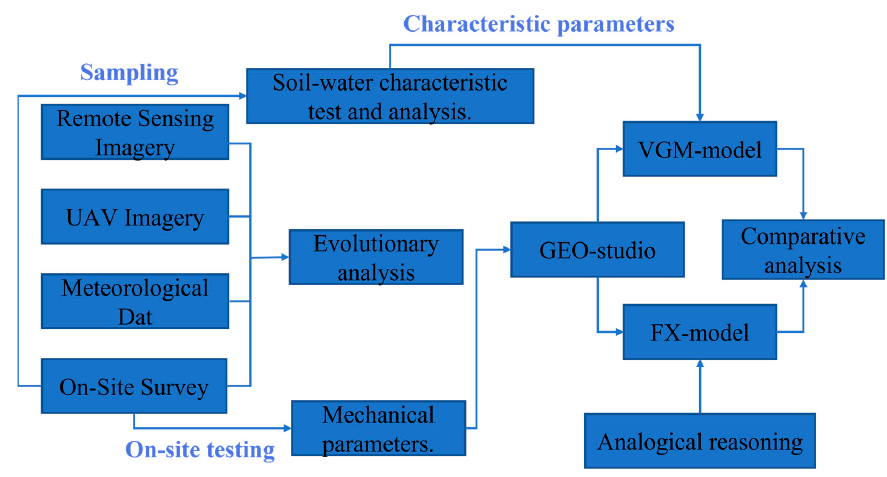
Figure 6. The flowchart of the entire article.